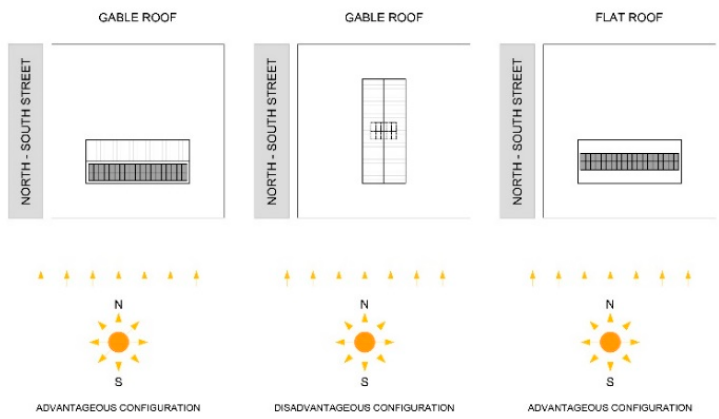
Figure 3. Possible positions of PV panels as function of an N–S street orientation (diagram by W. Celadyn, P. Filipek).